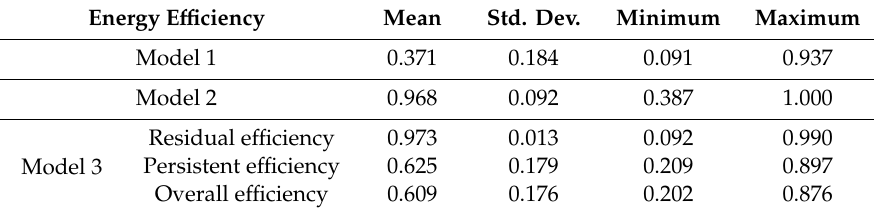
Table 5. Descriptive Statistics for Energy E ffi ciency Measures by Di ff erent Models.